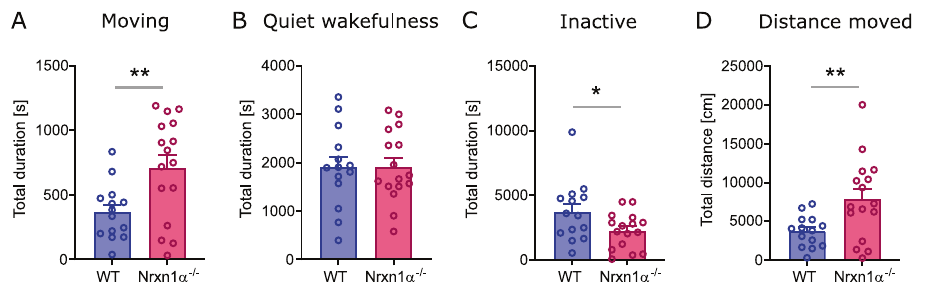
Fig. 1 Time spent in basic behavioral states. A total duration of time spent moving, B being in a quiet wakefulness state, C being inactive (including sleep), and D total distance moved. WT ( N = 14) displayed in blue, Nrxn1 α − / − ( N = 16) shown in magenta. Each datapoint represents one animal. Data displayed as mean + SEM. Two-tailed Student ’ s t -test. * p < 0.1, ** p <